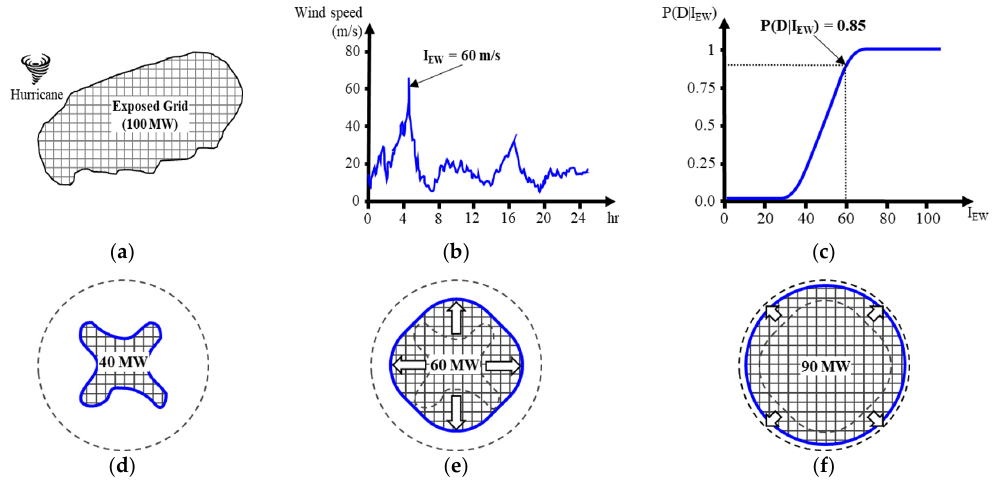
Figure 5. Simplified illustration of the grid resilience assessment. ( a ) Grid exposure; ( b ) wind speed profile; ( c ) grid vulnerability curve; ( d ) physical durability; ( e ) operational versatility; and ( f ) rehabilitation capacity.